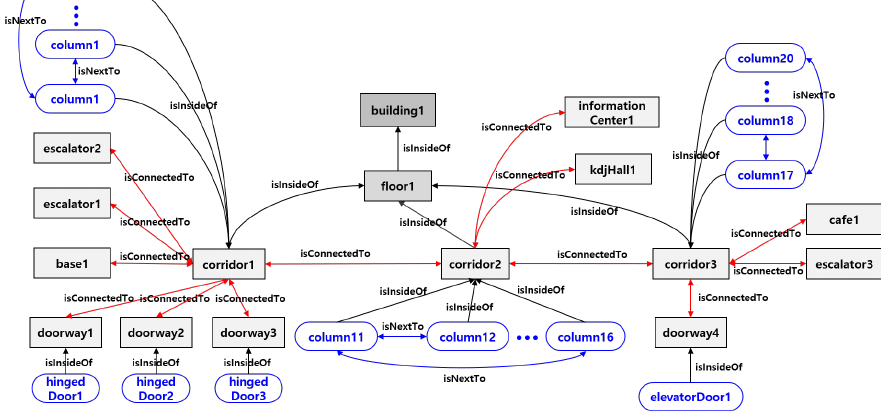
Figure 11. The TOSM-based database for experiments.